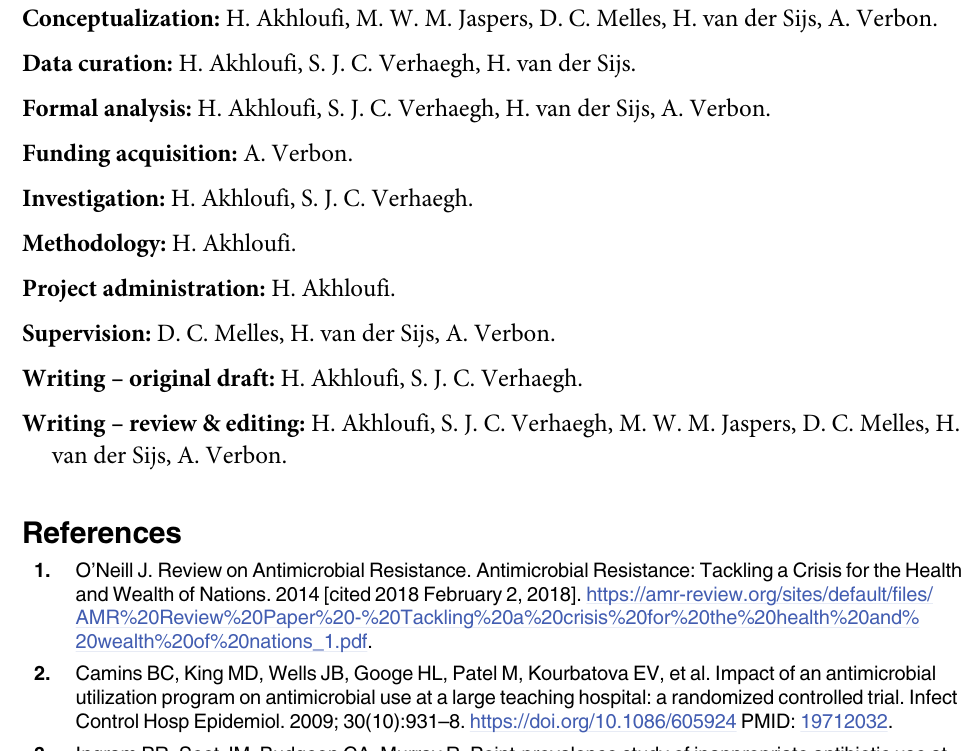
S1 Table. The four test cases that were used to test the usability of the CDSS.